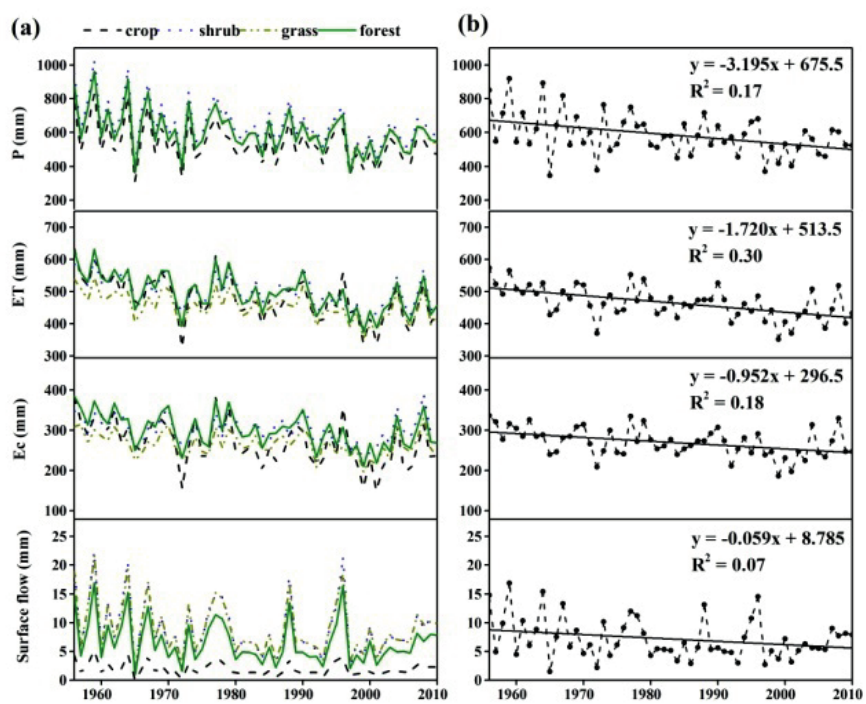
Fig . 3 The variations of annual precipitation (P), ET, Ec and surface flow for 1956–2010. (a) is for each vegetation type, and (b) for the whole